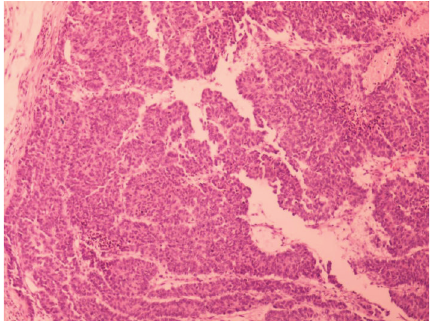
Figure 2: Mixed NET of the pancreas.